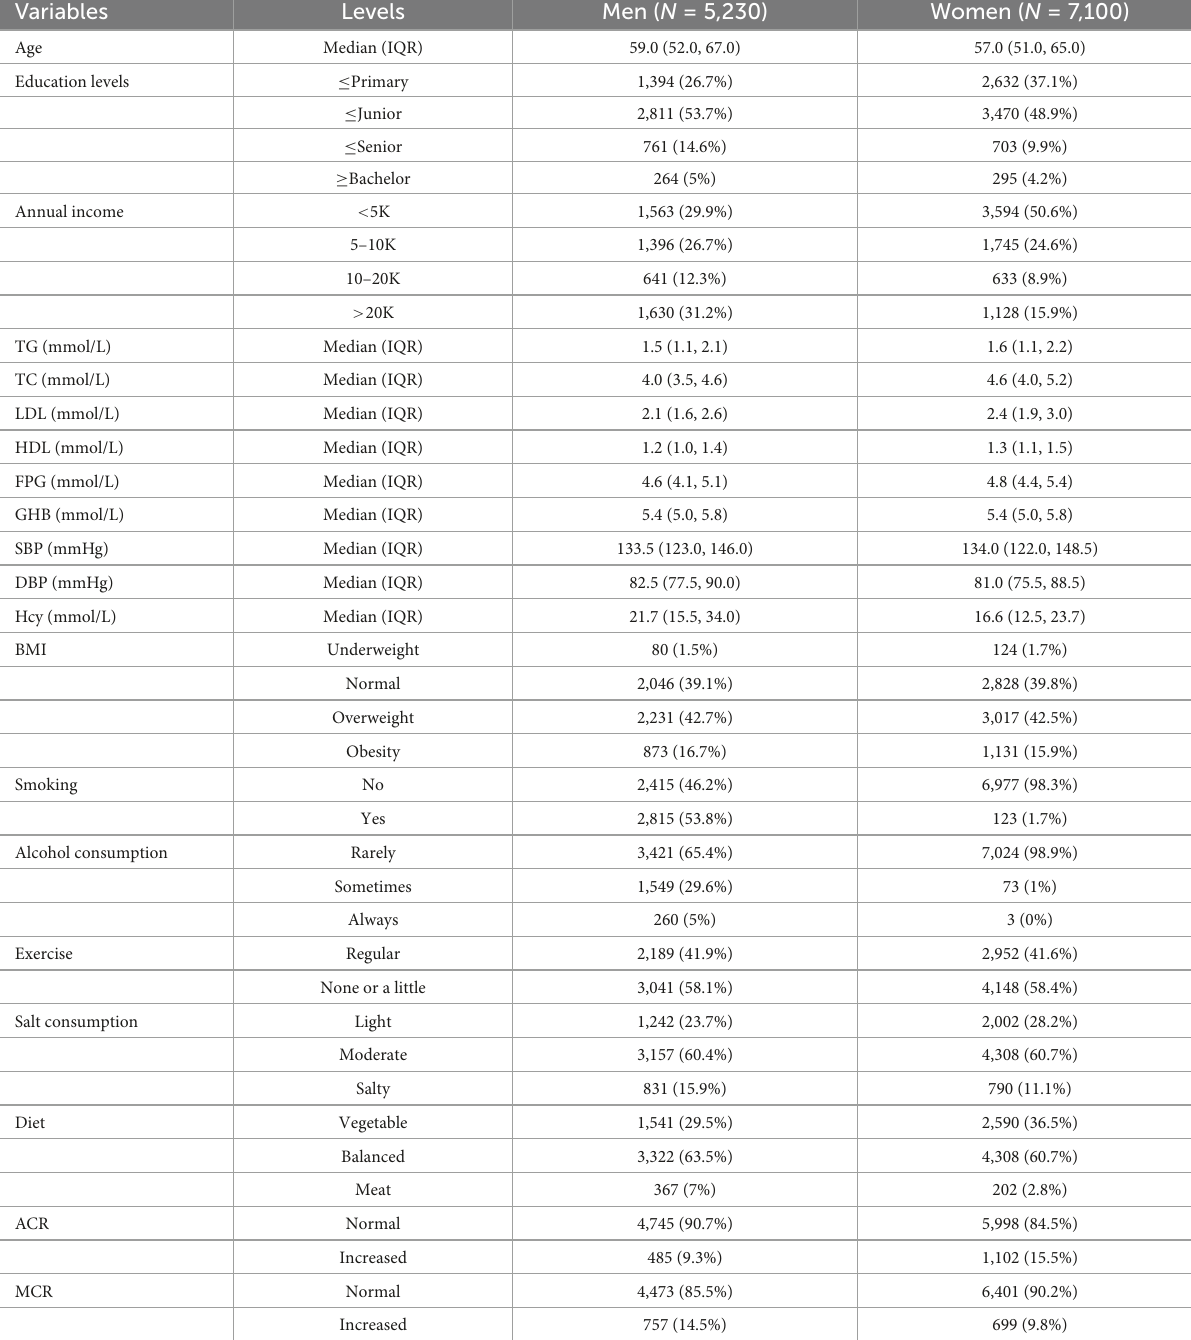
TABLE 1 Baseline characteristics of participants in this